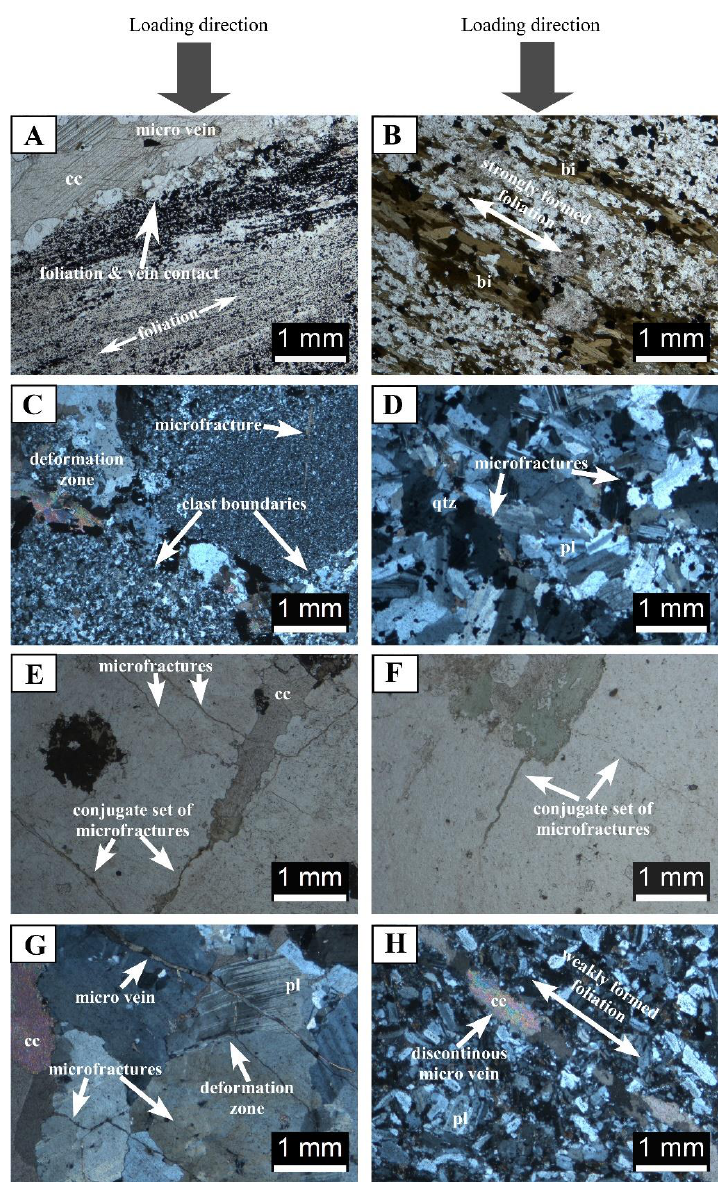
Figure 2. Microphotographs of the investigated samples showing the range of deformation features not visible in the hand sample. ( A ) Sample TE2B: sub-parallel quartz—plagioclase mylonitic foliation that is cross cut by a late stage calcite micro-vein. ( B ) Sample TE1C: biotite rich foliation bands. ( C ) Sample TE2D: clast-supported breccia with deformed zones of matrix and micro-fractures within the anorthosite clasts. ( D ) Sample TE3C: tonalite with micro-fractures. ( E ) Sample TE3B: tonalite with micro-veins and conjugate sets of micro-fractures. ( F ) Sample TE1B: tonalite with conjugate sets of micro-fractures. ( G ) Sample TE3B: tonalite with deformation zones between plagioclase and quartz grains, micro-veins and micro-fractures. ( H ) Sample TE1A: anorthosite with a discontinuous calcite micro-vein following weakly formed